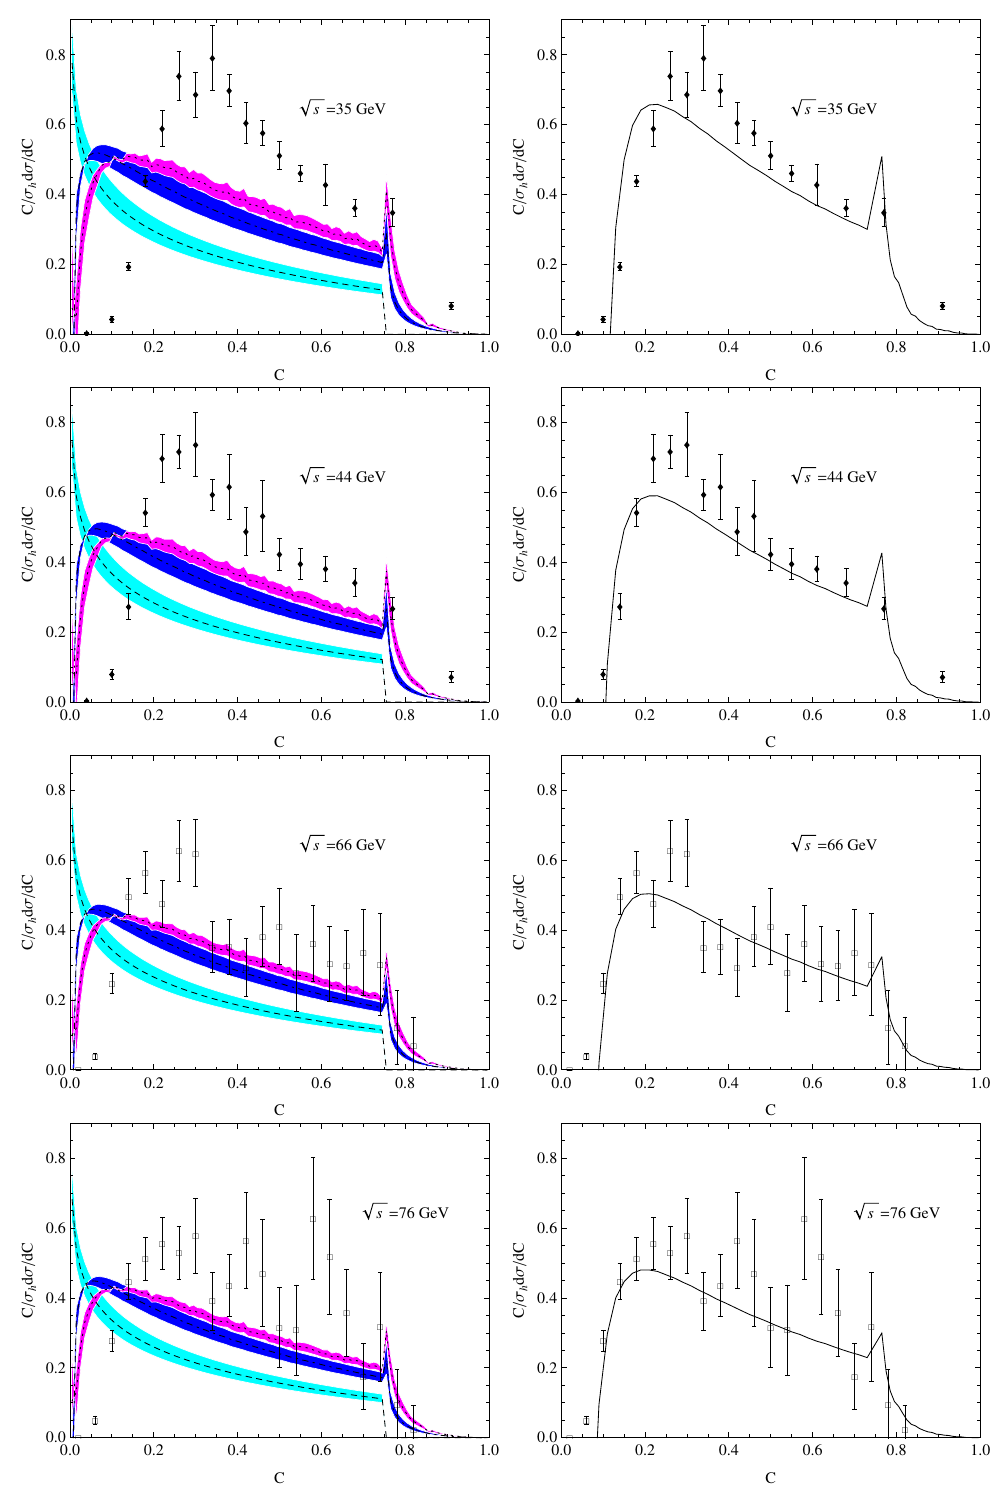
Figure 11. The C -parameter ( C ) distributions using conventional (left column) and PMC (right column) scale-settings for taken from the JADE [56, 57], and